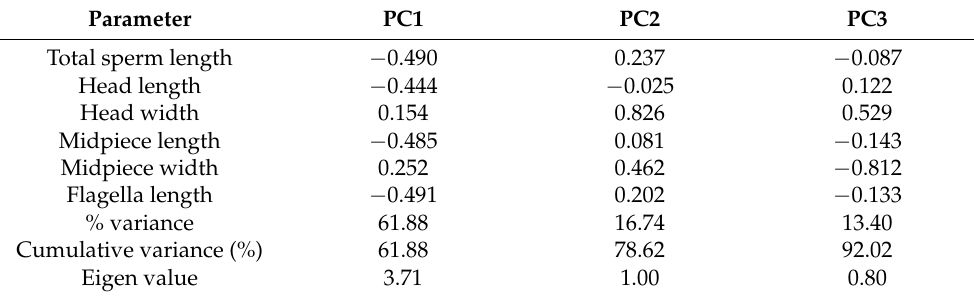
Table 1. Individual weightings for sperm size measurements, the individual % variance, cumulative % explained variance and eigen values of the three top principal